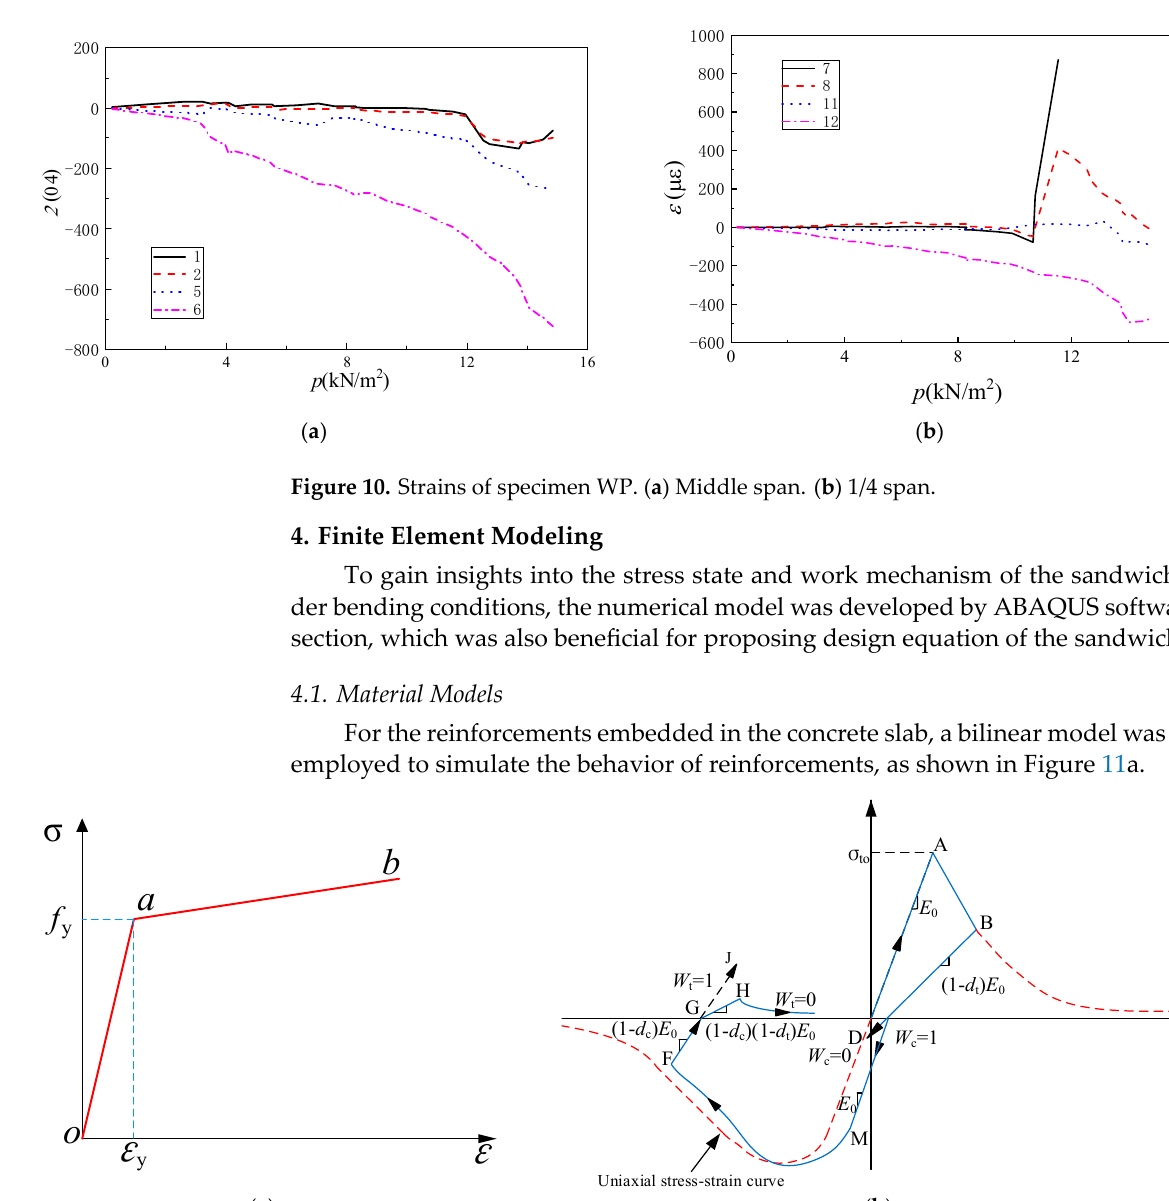
Figure 9. Strain distributions.